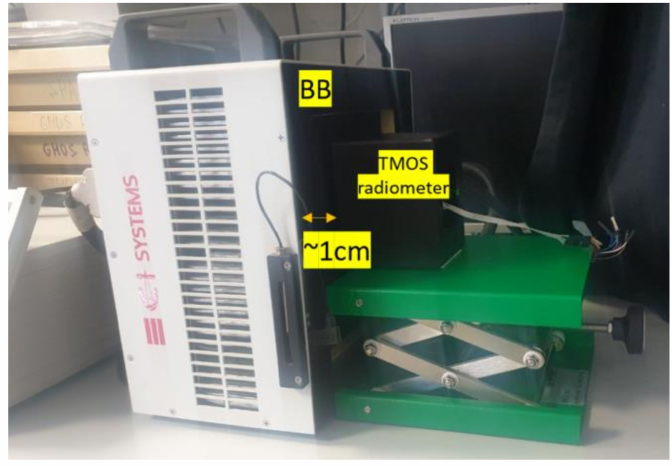
Figure 10. The calibration